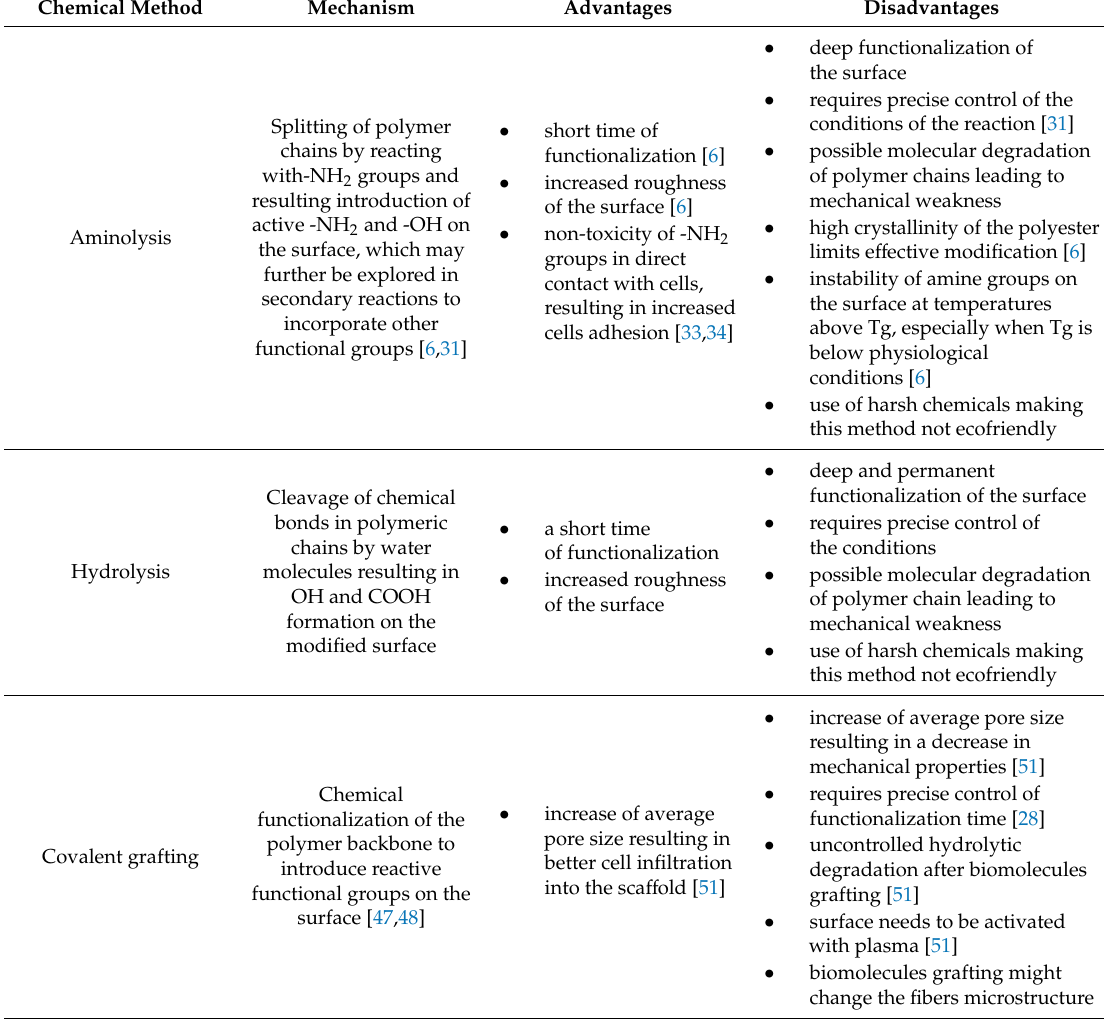
Table 1. Comparison of chemical methods of hydrophilic functionalization of electrospun nanofibers. Chemical